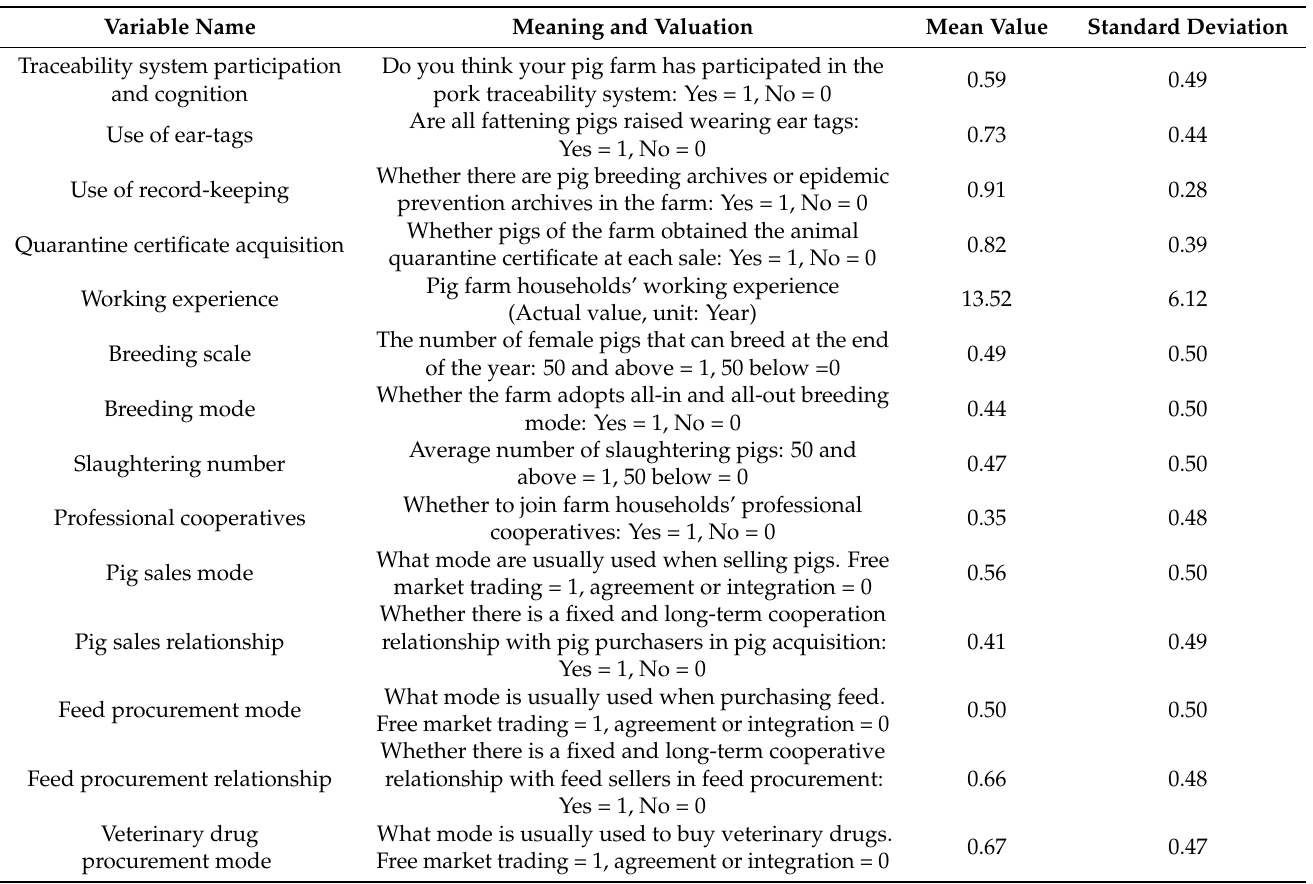
Table 1. The definition of independent